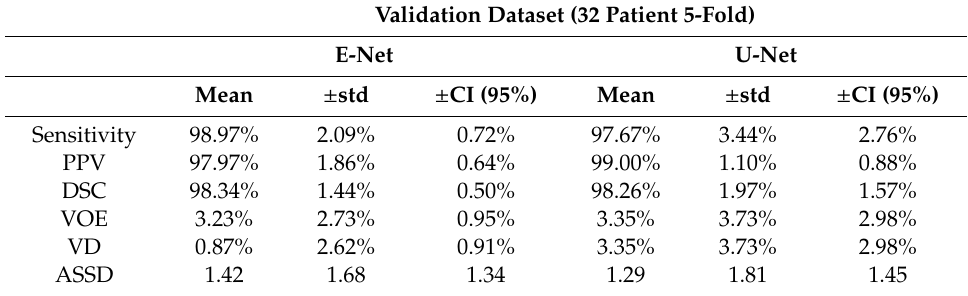
Table 1. Performance results for the validation dataset obtained as the average of the results computed in each loop of the five-fold cross-validation strategy.